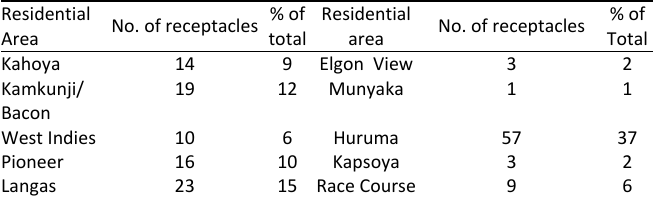
Table 3: Distribution of “Din” standard containers (The Director of Environment and Enforcement, 2018)